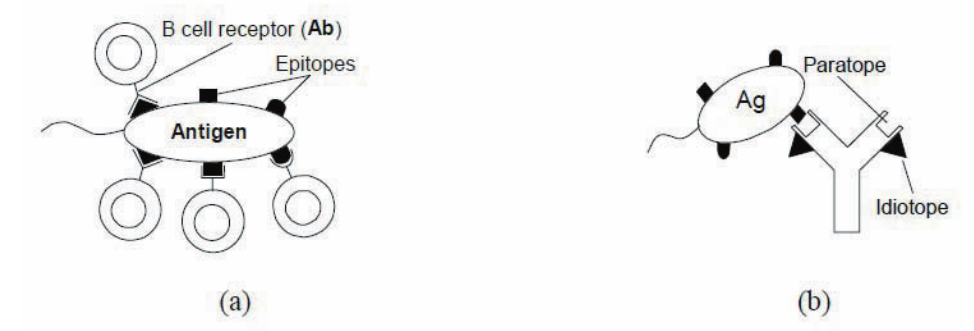
Fig. 2. B cell, antigen, antibody, epitopes, paratopes and